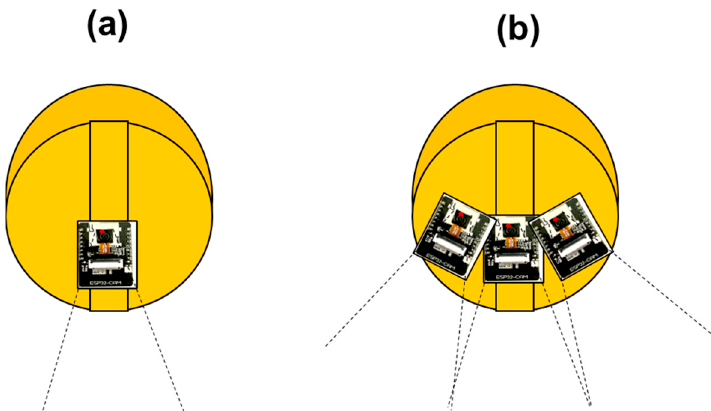
Figure 14. Comparison of recognition angles when there is one camera module ( a ) and three camera modules ( b ) on the AI Smart Helmet PWS system.